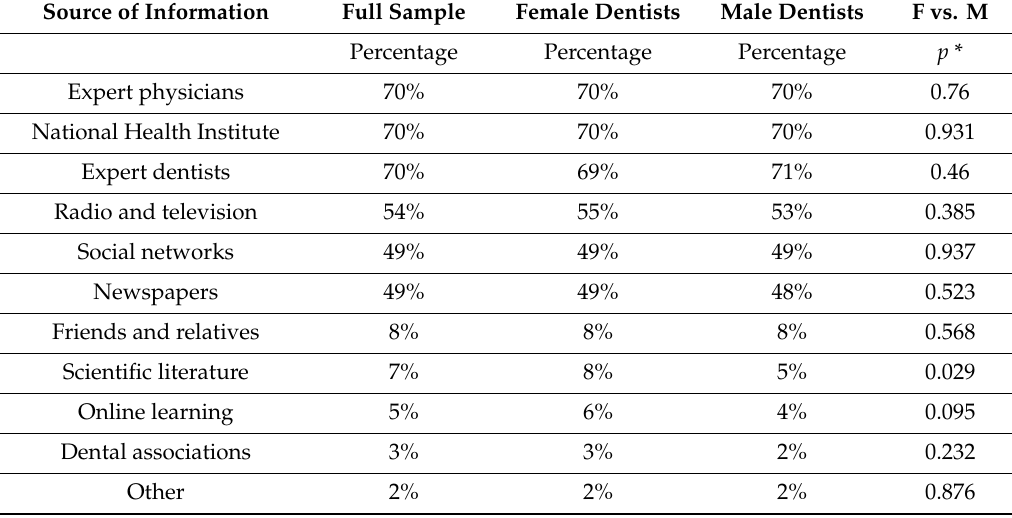
Table 4. Sources of information regarding COVID-19 in the full sample and in the groups of female and male dentists.